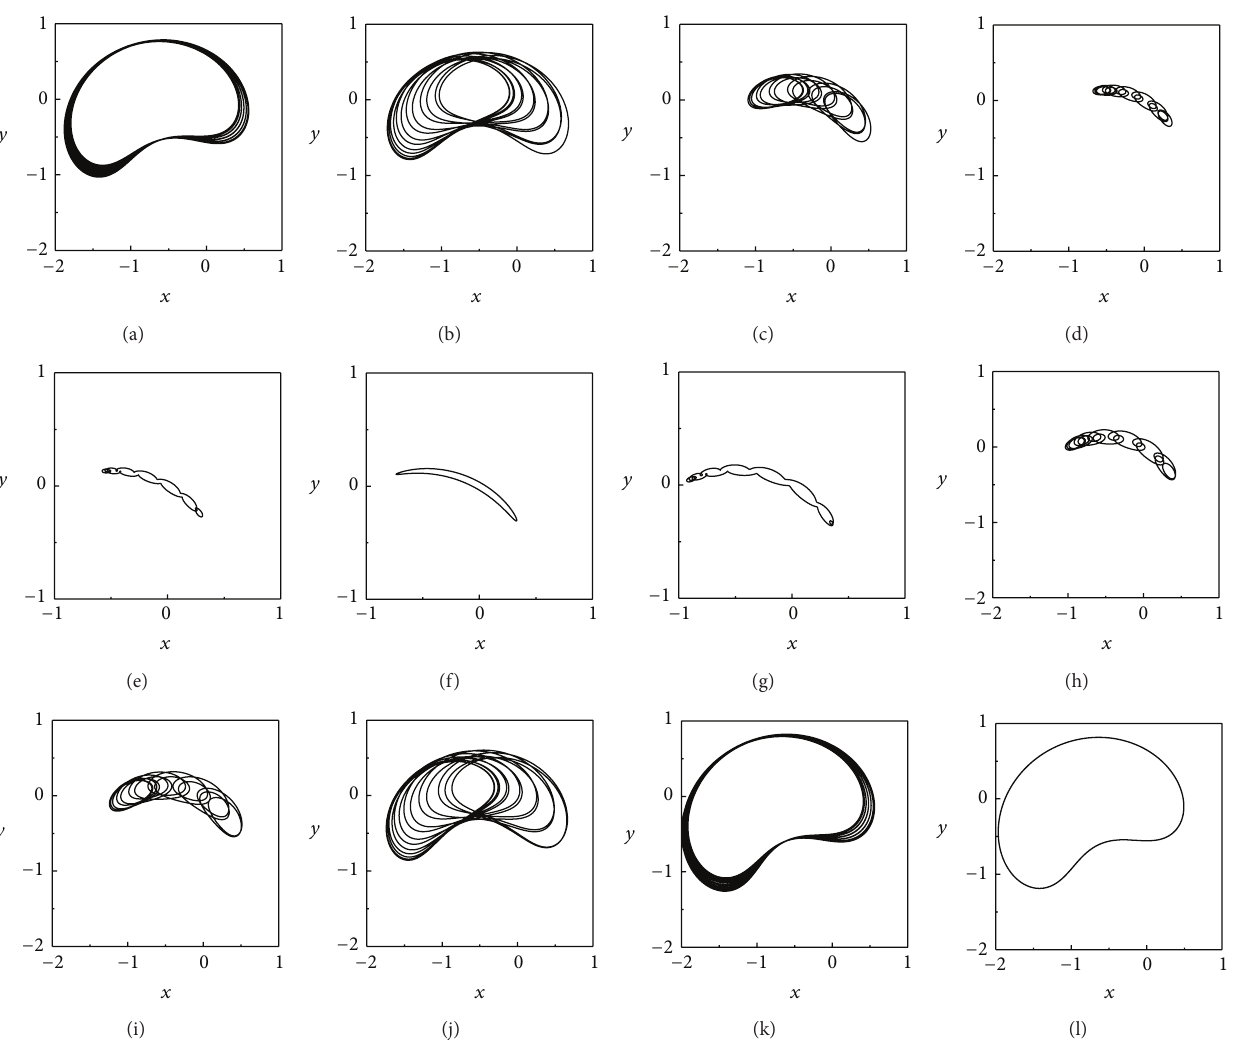
Figure 8: The evolution of the branch 𝐿 14 13 of the long period family by plotting sample periodic orbits. Note that the coordinate system has been transferred to the equilibrium point 𝐿 4 .